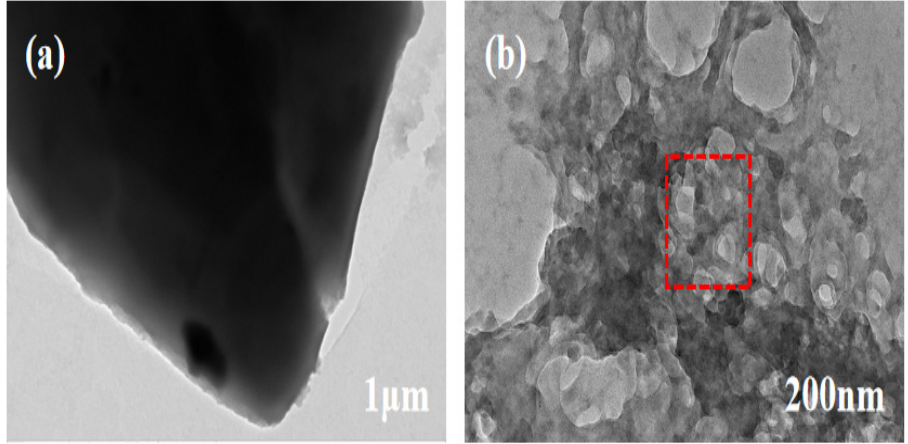
Figure 9. FE − SEM micrograph of germanium–tannins ( a , b ). Figure 9. FE-SEM micrograph of germanium–tannins ( a , b ).